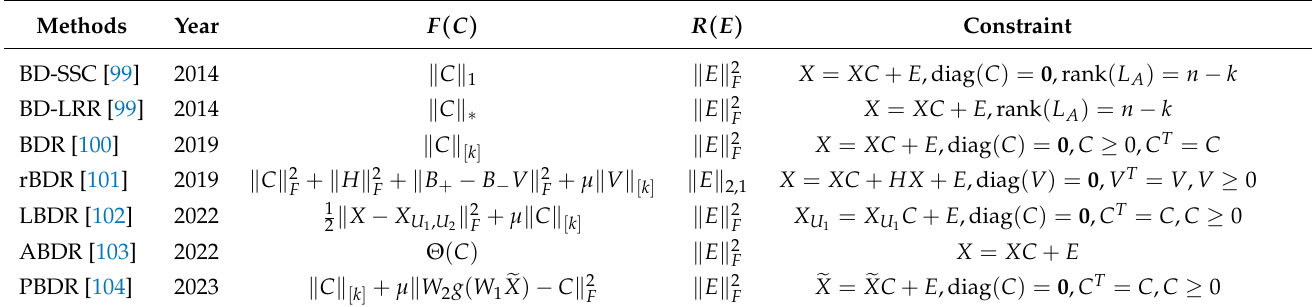
Table 7. The comparison of classical block diagonal representation SC